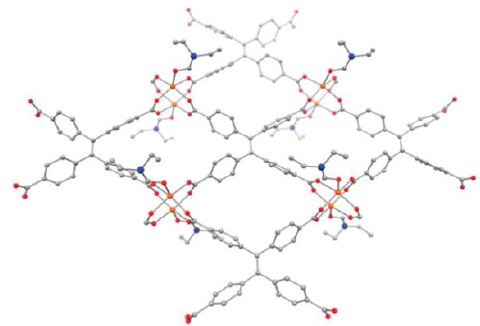
Figure 24. Crystal structure of the fluorescent Zn 2 (TCPE) framework. Reproduced with permission from [25]. Copyright American Chemical Society,